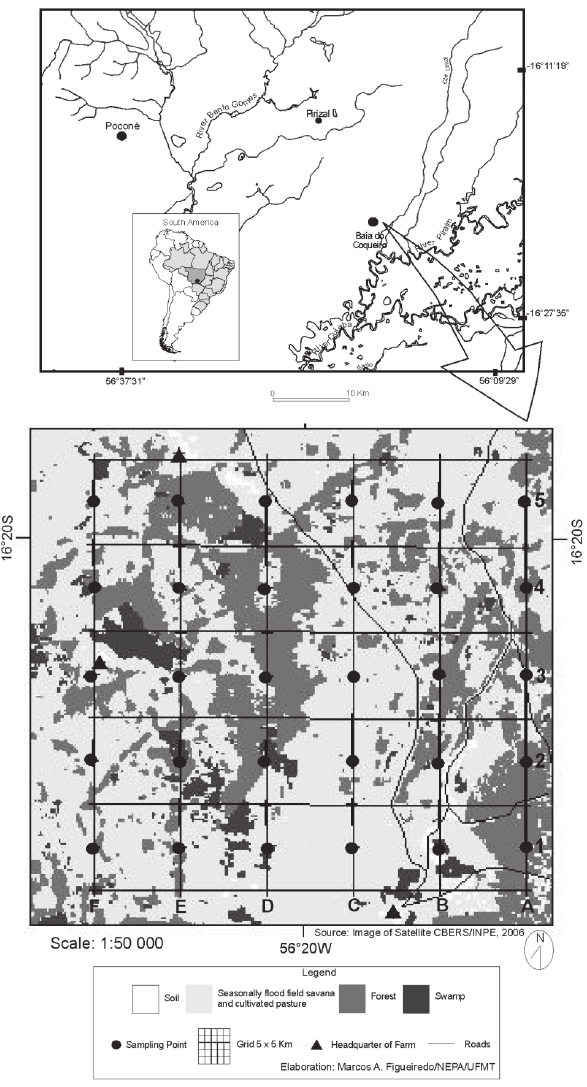
Figure 1. Map of the study area located in the Pantanal, near Poconé, and map of the sampling grid showing the 30 sampling plots distributed in different